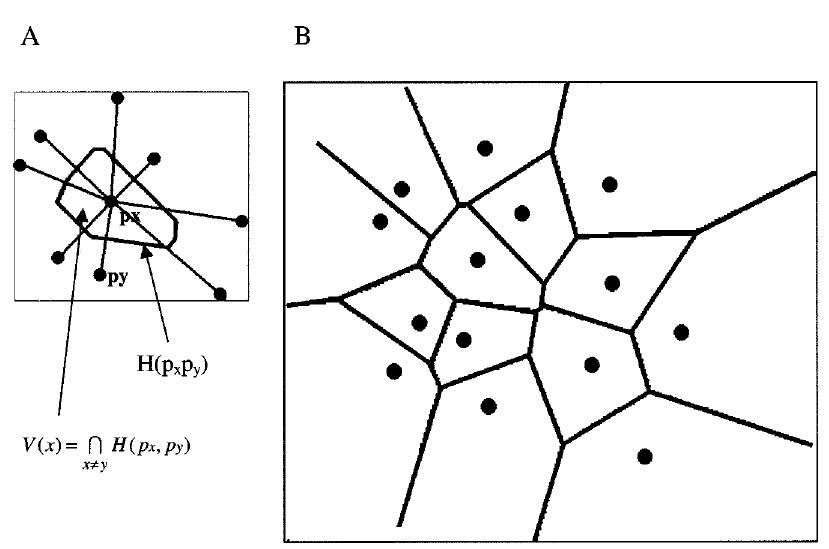
Fig. 1. A single Voronoi polygon, V x (Panel A) is defined by the halfplanes H ( p x p y ) that perpendicularly bisect the lines between a centre point and its neighbouring pointlike seeds. When we use this rule for every point considered, the area of interest is completely covered by adjacent polygons, constituting the Voronoi Diagram (VD). Panel B shows the VD for a set of randomly distributed pointlike seeds in a flat plane.